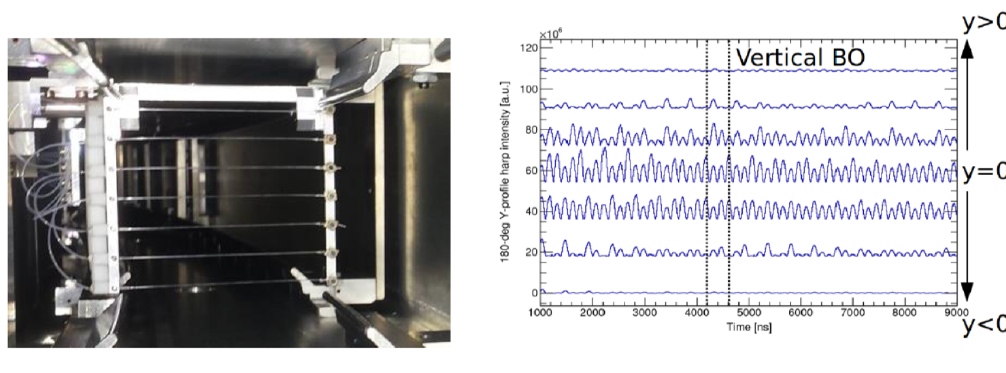
Figure 4. ( Left ) The image of a fiber harp; and ( Right ) the beam profile in y direction measured by the fiber harp. Vertical BO means the vertical component of the betatron oscillations.